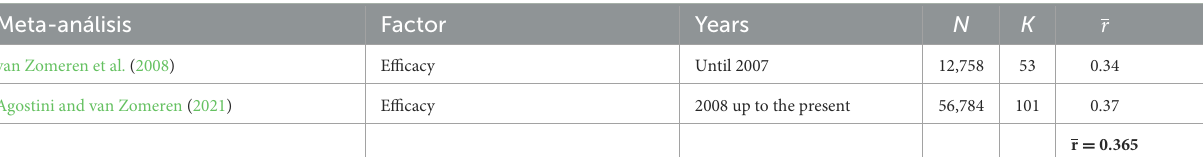
TABLE 4 Efficiency relationship with SM and